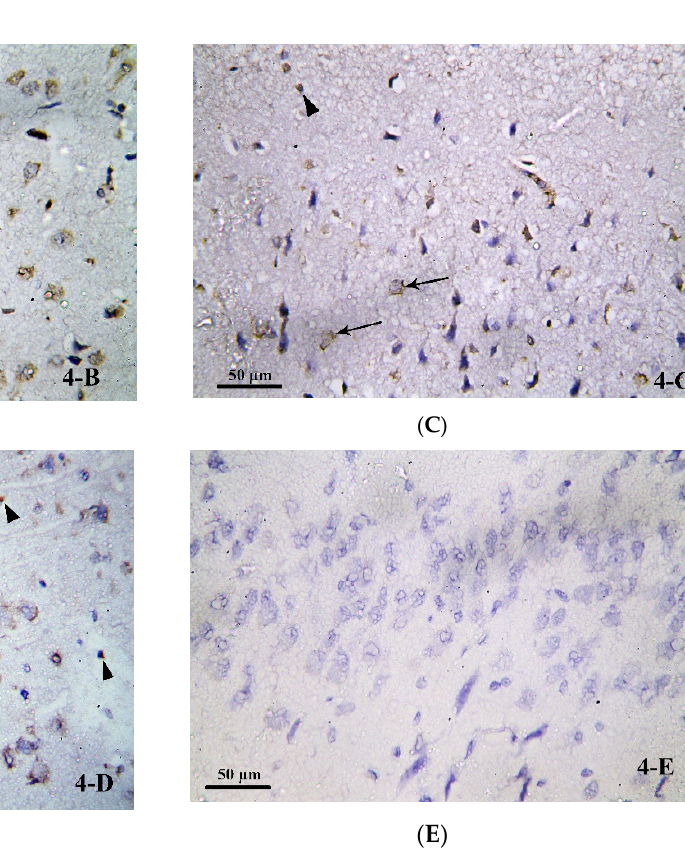
Figure 4. Photomicrograph of brain tissue from ( A ) Group I, showing a negative caspase-8 immune- reaction in nerve cells and glial cells in the frontal cortex of the control group. ( B ) Group II showed positive immune-reaction to caspase-8 in the cytoplasm of some nerve cells ( ↑ ) and glial cells ( ▲ ). ( C ) Group III showed a positive immune-reaction to caspase-8 in the cytoplasm of some nerve cells ( ↑ ) and glial cells ( ▲ ). ( D ) Group IV, showing a positive immune-reaction to caspase-8 ( ↑ ) in the cytoplasm of some nerve cells and glial cells. ( E ) Group V showed a negative caspase-8 immune- reactions in nerve cells and glial cells in the frontal cortex of group V. (Avidin Biotin Peroxidase for Caspase-8 × 400).